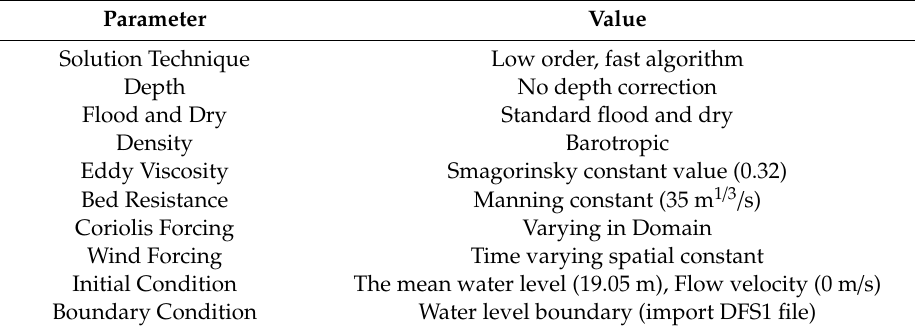
Table 3. Hydrodynamic model parameter setting.